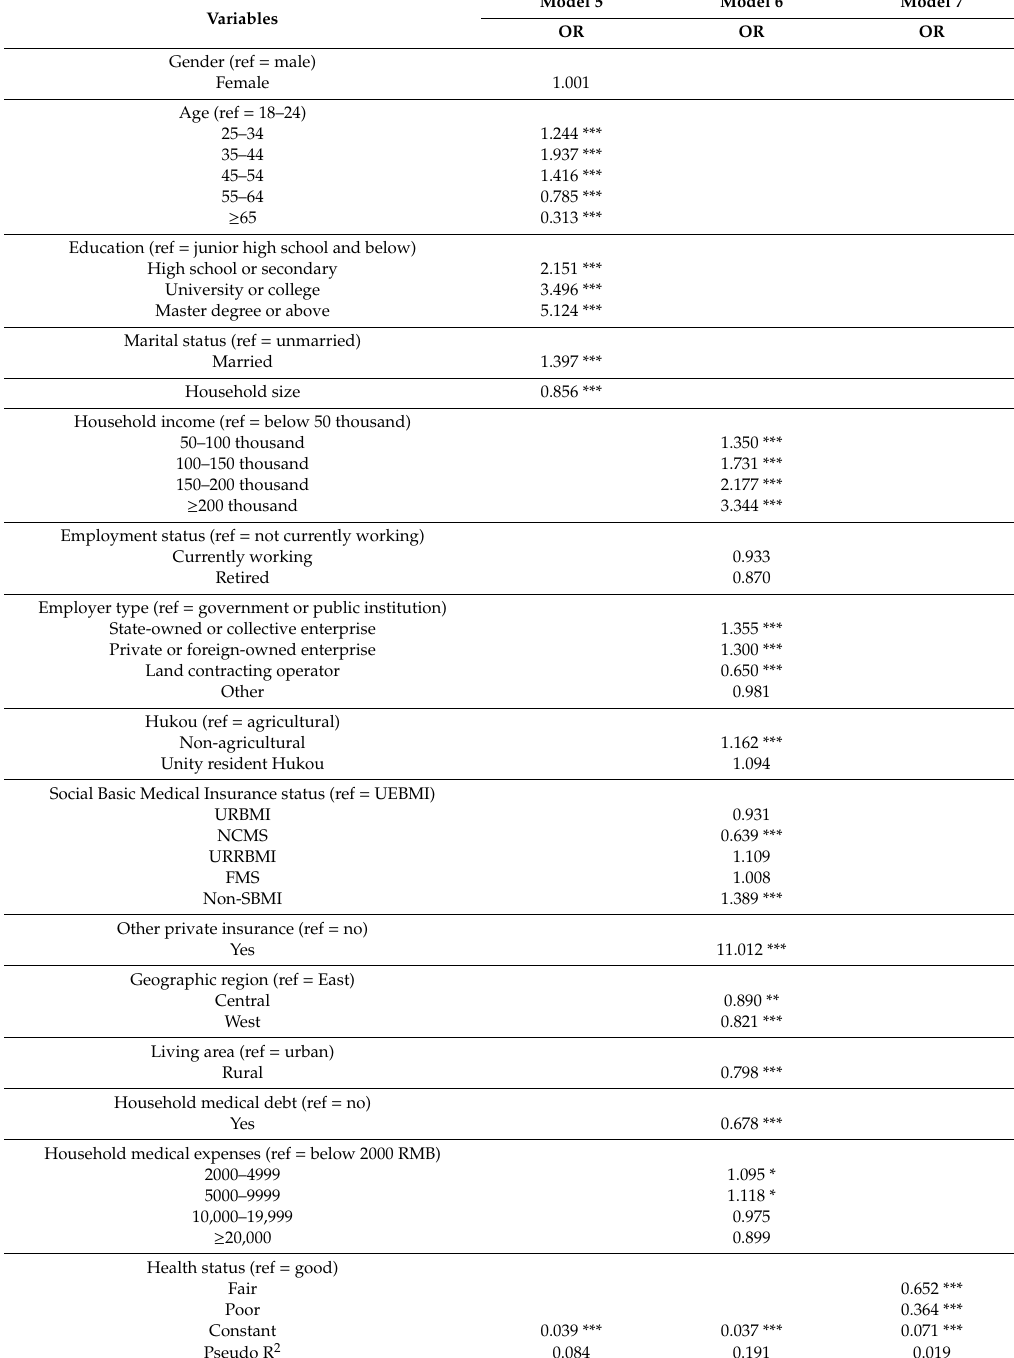
Table A2. Binary logistic regression analysis of each set of predictors of PHI